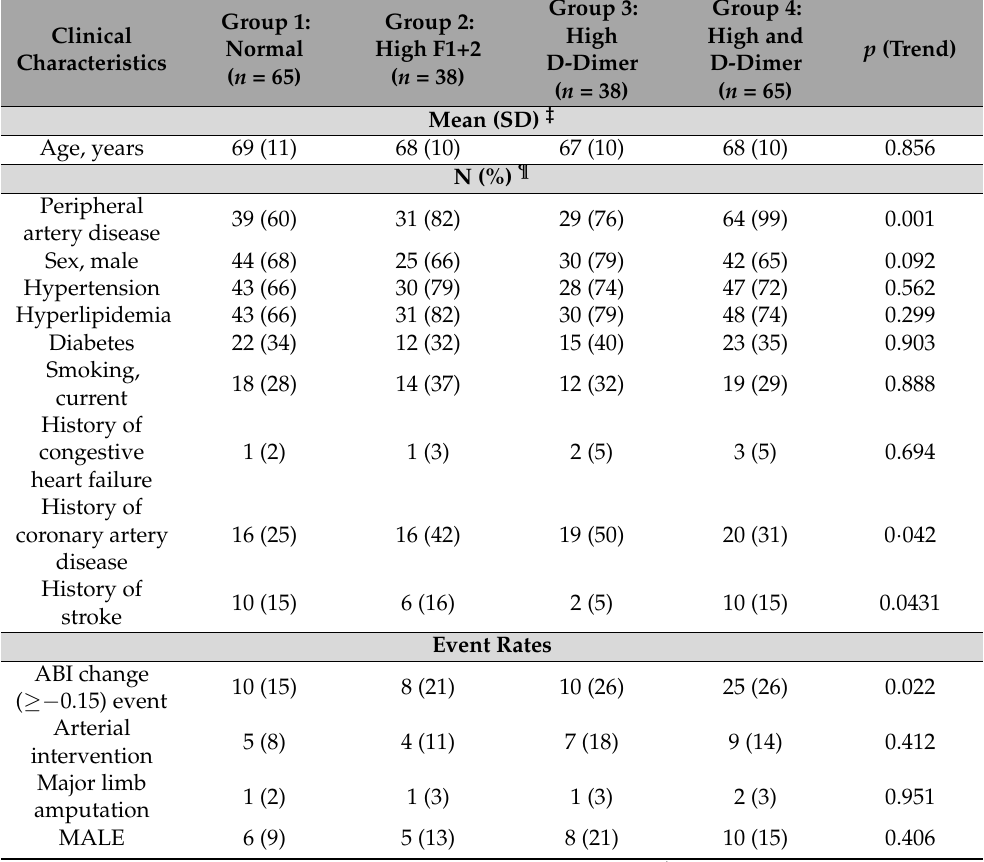
Table 3. Clinical characteristics of subgroups based on the median values of F1+2 and D-dimer.